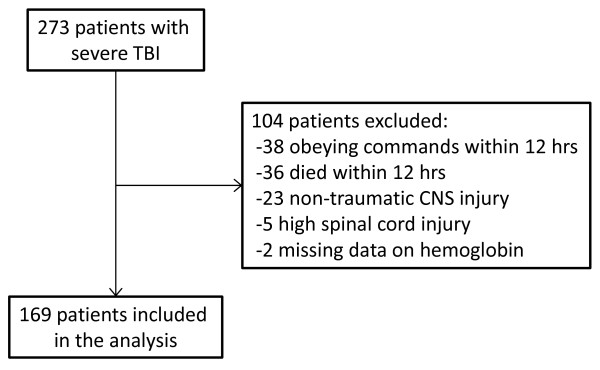
Total patients screened and then included in the final analysis. Reasons for exclusion are shown. CNS, central nervous system; TBI, traumatic brain injury.